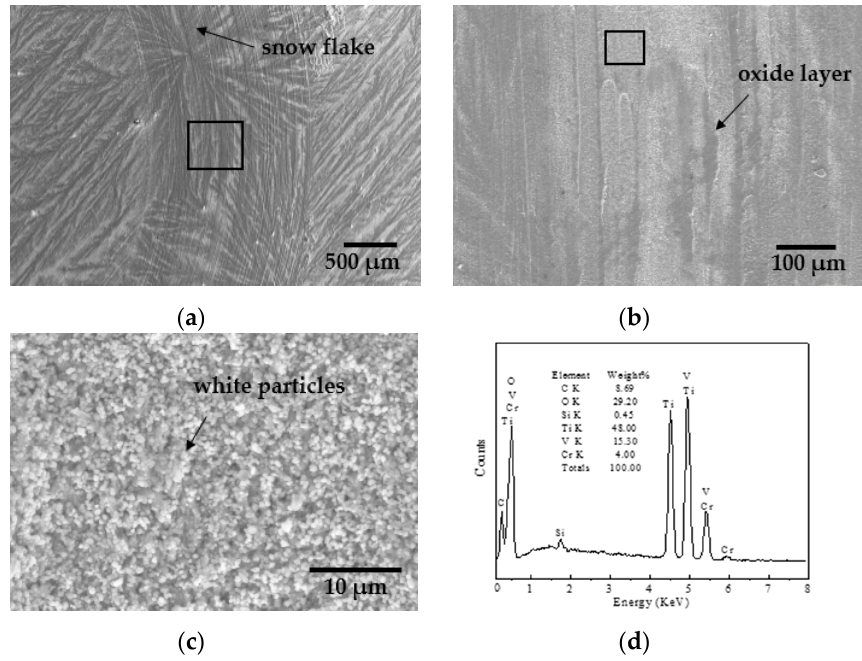
Figure 9. SEM morphologies and EDS spot ‐ analysis of the worn surface in TF550 alloy after wearing at 1073 K. ( a ) Low magnification SEI; ( b ) high magnification SEI of area in black square in ( a ); ( c ) SEI of area in black square in ( b ); ( d ) compositions of the white particles region.